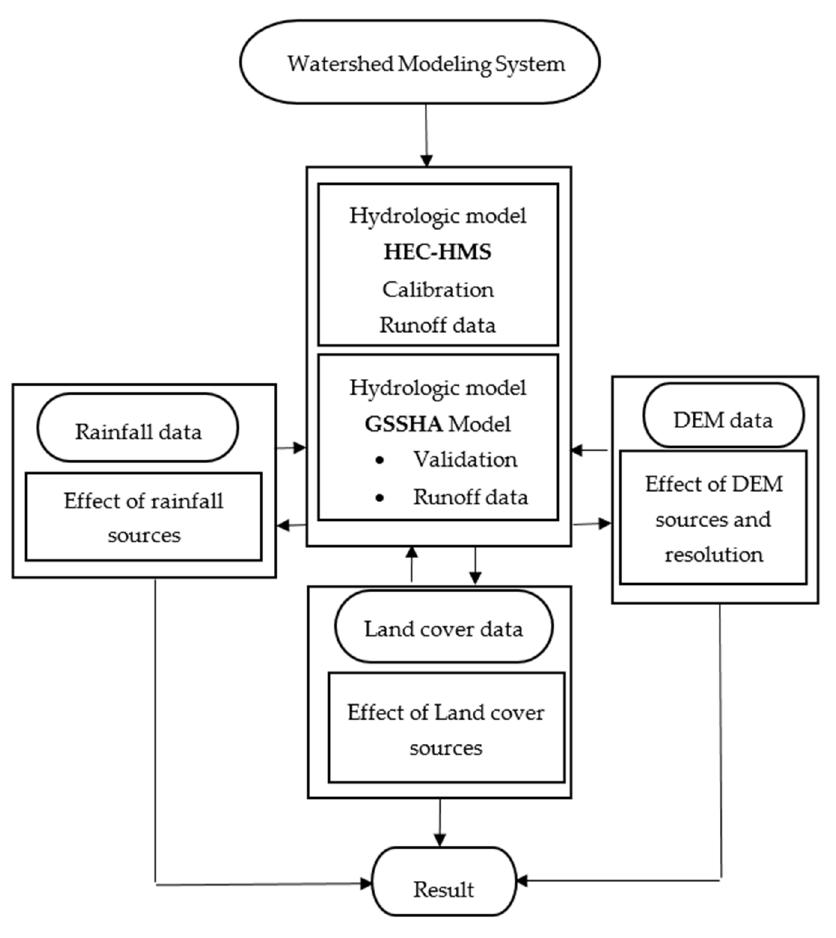
Figure 8. General framework of the modeling methodology.